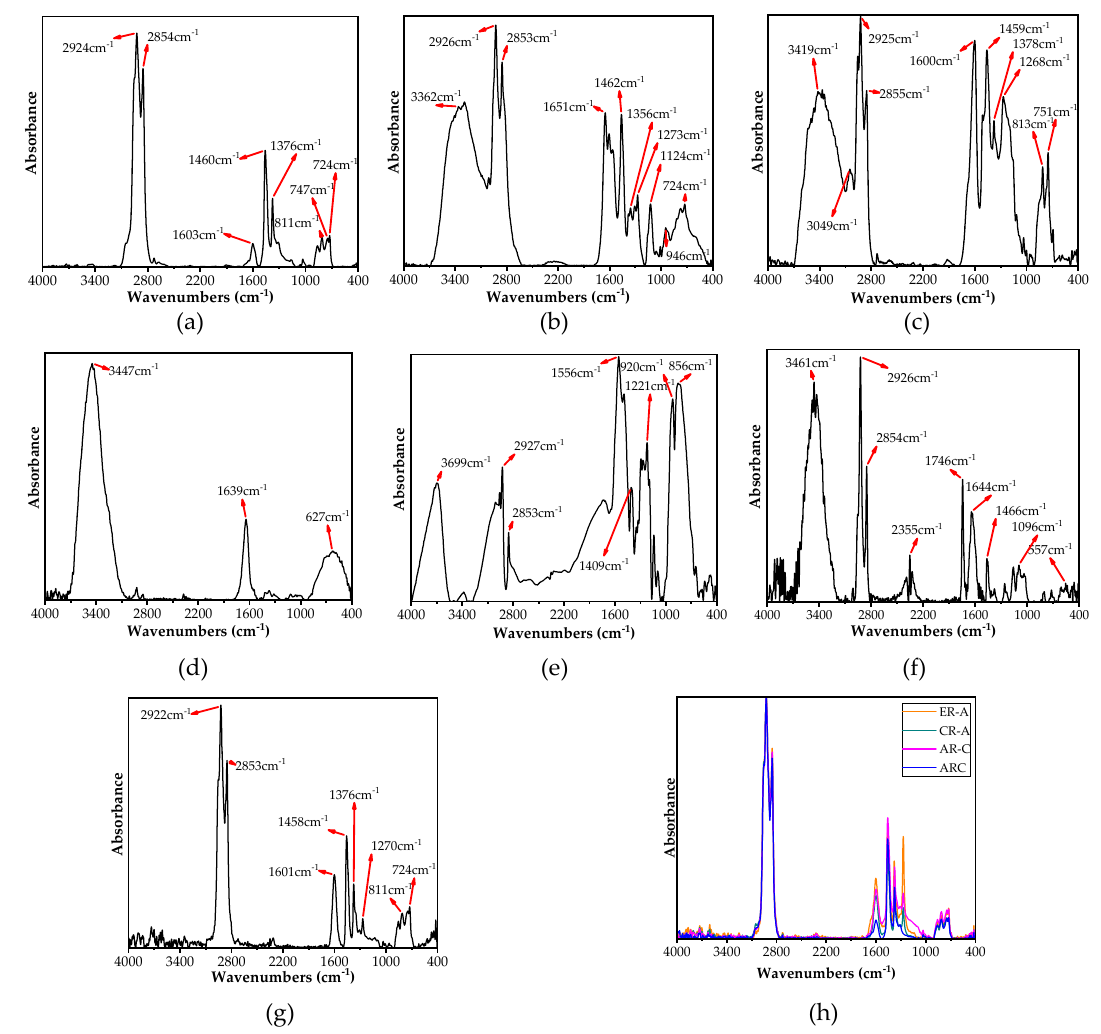
Figure 9. FTIR test results: ( a ) Base binder, ( b ) Evotherm–DAT, ( c ) HBO, ( d ) CRM, ( e ) E – CRM, ( f ) B – CRM, ( g ) AR, and ( h ) Evotherm–DAT and HBO modified binders.